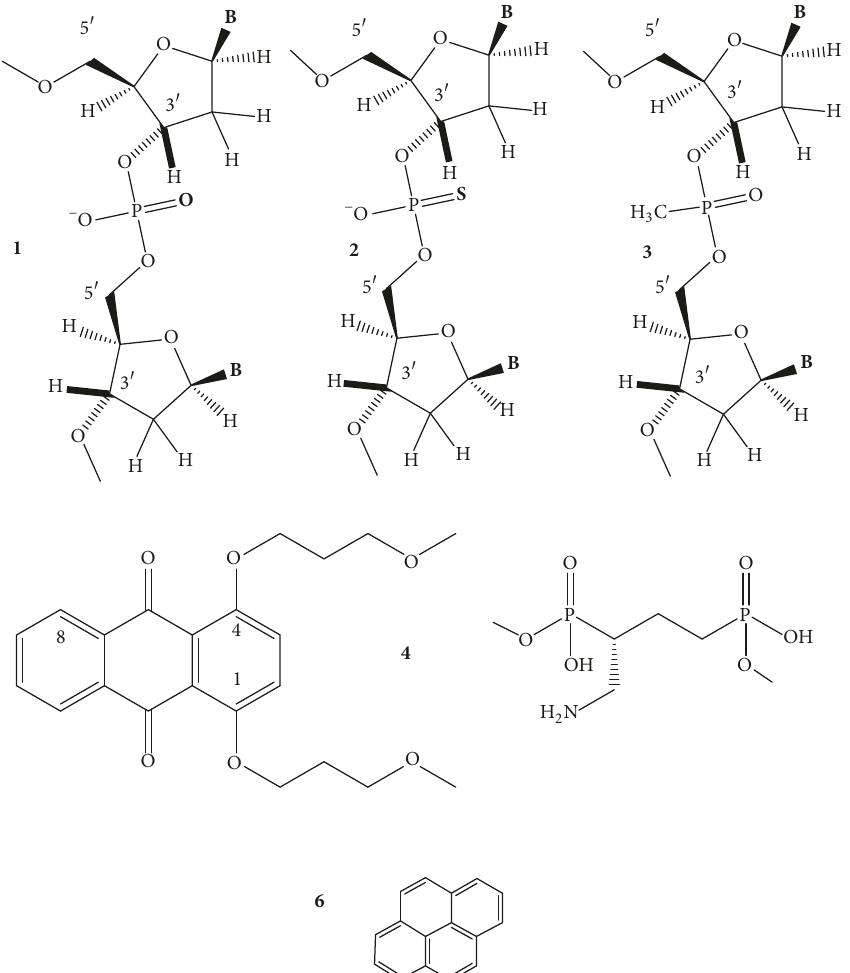
Figure 12: 2 󸀠 -Deoxydinucleotides connected by the natural phosphodiester (P-O) ( 1 ); the thiophosphoryl or phosphorothioate (P-S) ( 2 ) and the nonionic methylphosphonate (P-Me) linkages ( 3 ); the 1,4-disubstituted dihydroxyanthraquinone linker ( 4 ); the acyclic (R)-4- aminobutane-1,3-diol phosphodiester backbone ( 5 ); and the pyrene molecule used for loop ( 6 ).